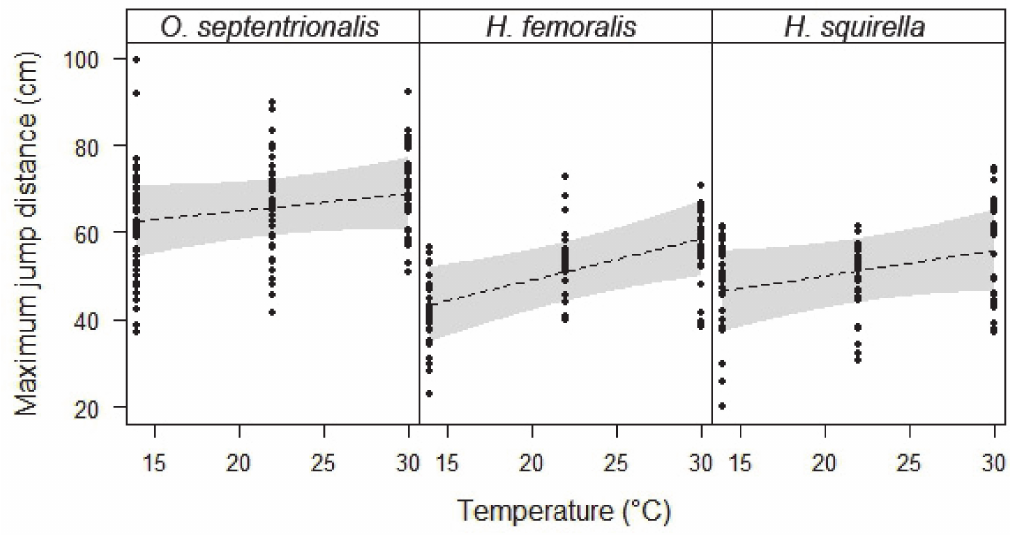
Figure 2. Maximum jumping distance of O. septentrionalis , H. femoralis , and H. squirella across temperatures. These plots are conditional plots with fitted regression line (dotted line), partial residuals (dots), and 95% confidence bands (shaded) that control for all factors in the statistical model that are not shown in the figure (see Table 1).